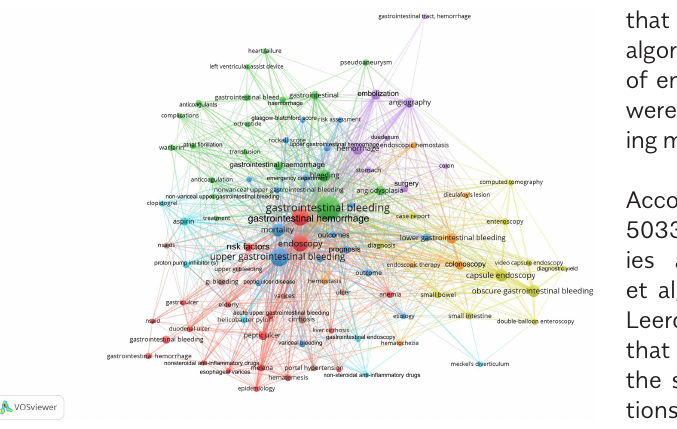
Figure 6. Network visualization map for cluster analysis based on keyword analysis on gastrointestinal bleeding. Colors show clustering. Keywords in the same cluster are of the same color. The circle size increases with the number of times the keyword is used.